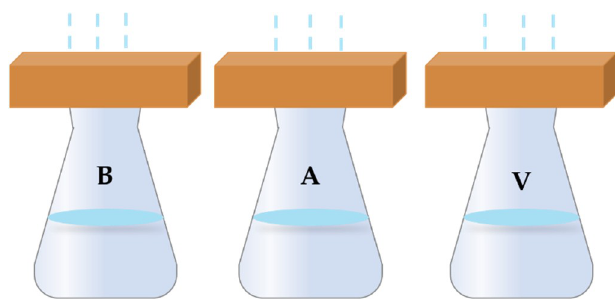
Figure 2. Schematic diagram of water vapor permeability